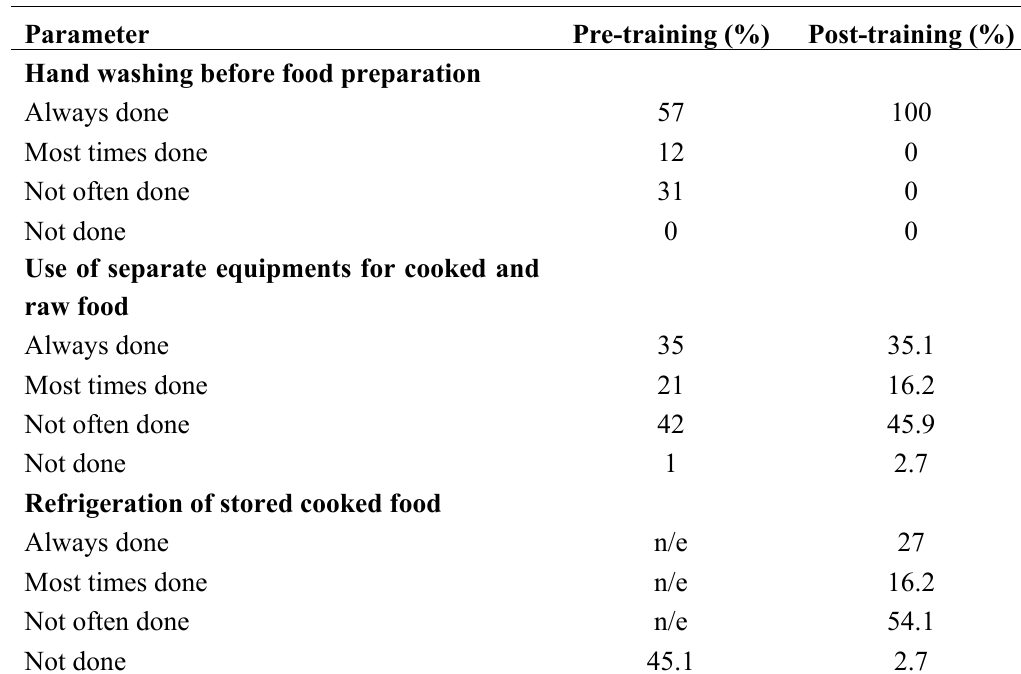
Table 2. Impact of training and self-reported food handling practices of vendors, before and after the training workshop